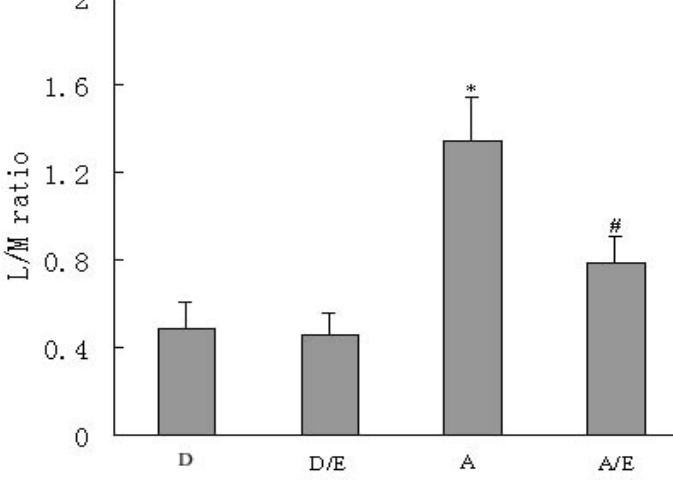
Figure 2. Effect of ethanol and EGCG on L/M ratios in rats. Chronic alcohol administration significantly increased the L/M ratio compared with dextrose group (* p <0.01). EGCG concurrent treatment significantly lowered the L/M ratio compared with alcohol group (# p